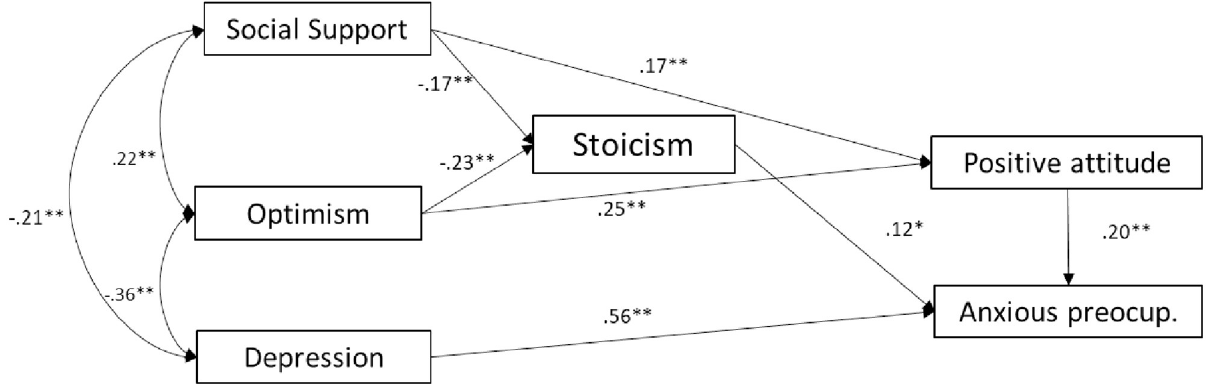
Fig 1. Tested study model: Relationship between stoicism and psychological variables in men. Note: Dashed lines indicate statistically non- significant paths. � p < 0.01; �� p <